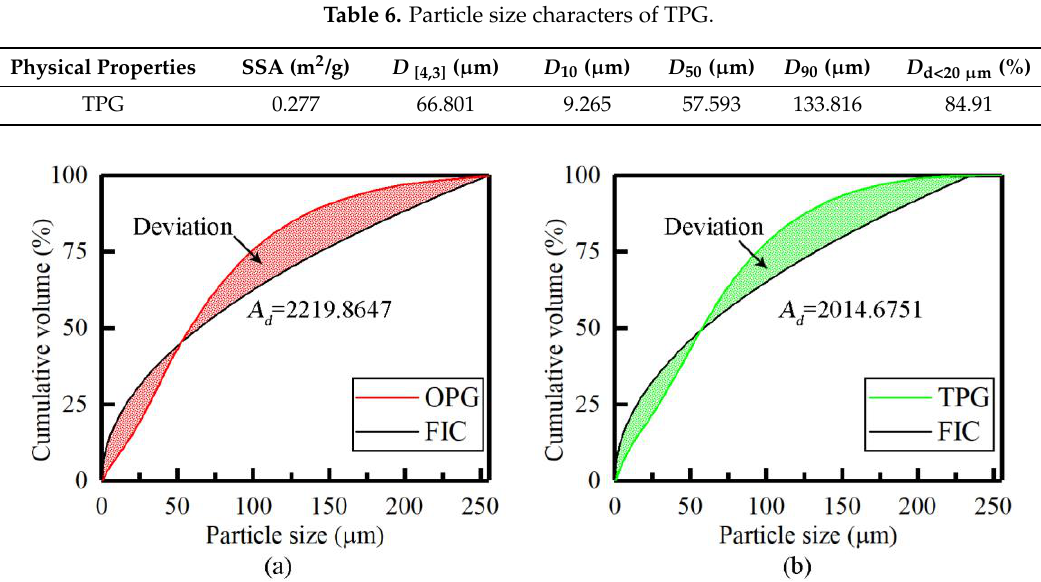
Figure 6. Particle size curve and Fuller ideal curve (FIC) of OPG ( a ) and TPG ( b ).